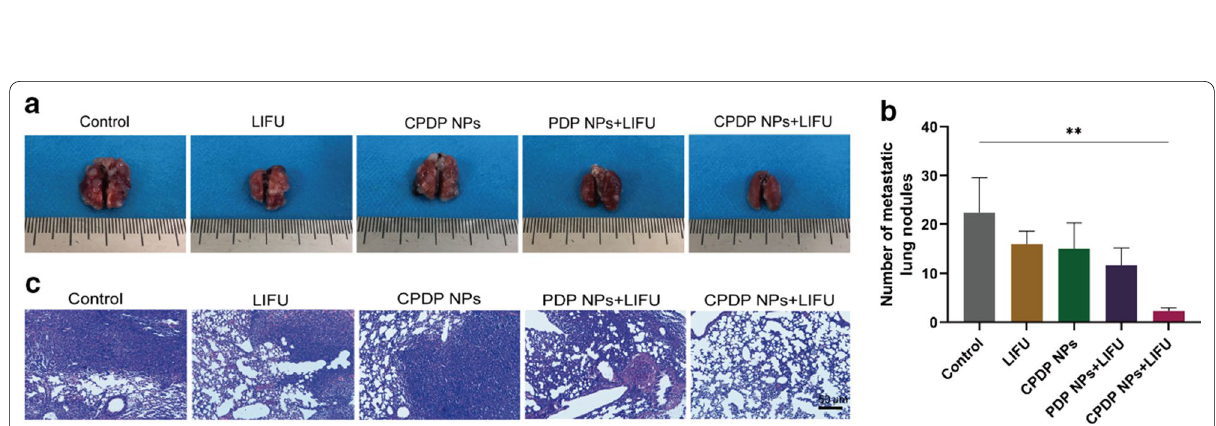
Fig. 10 a Images of the general appearances of lung tissues. b The analysis of the metastatic lung nodules between various treatments (** p < 0.01, n 3). c Corresponding images of lung metastatic H&E staining results (scale bar: 50 =